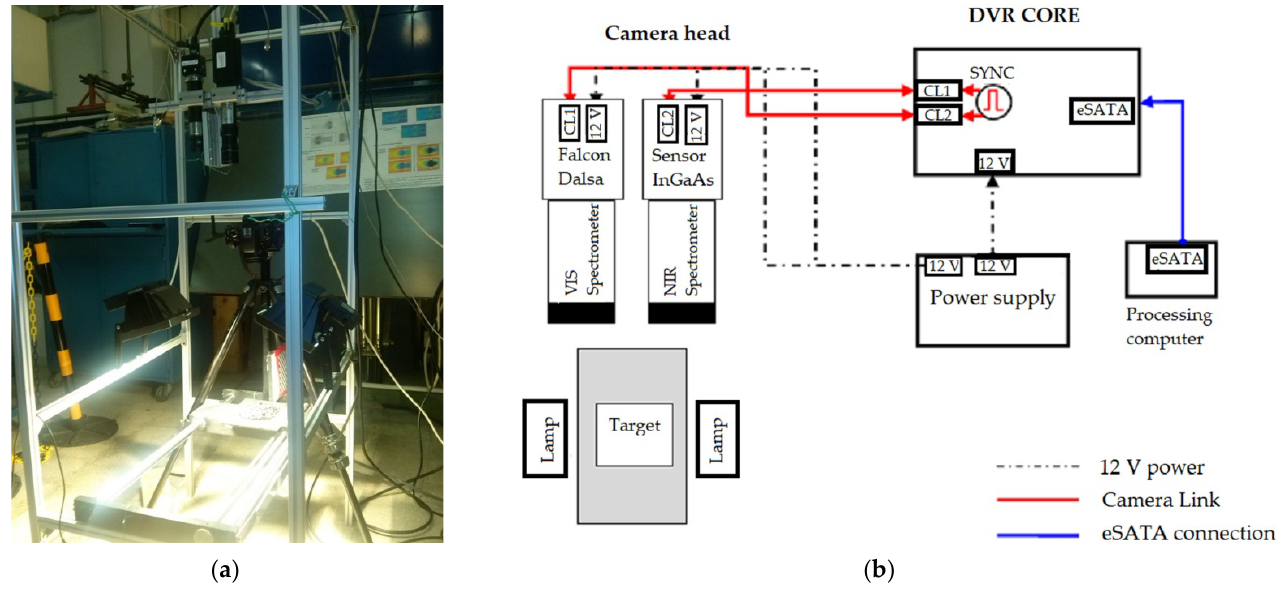
Figure 2. ( a ) Picture of the three-sensor platform used for this study, composed of conveyor belt, two light sources, digital camera, and VIS and NIR spectrometers; and ( b ) scheme of the hyperspectral device configuration.